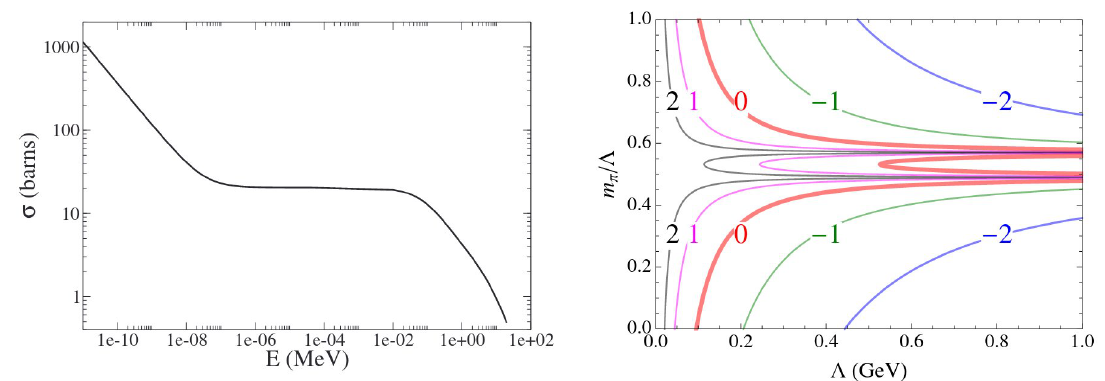
Figure 25: Left: actual neutron-proton scattering cross section as a function of center of mass energy. Plateau is the constant cross section of Eq. (50); at lower energies the [ σ/ m ] / [ 0.6cm 2 / g ] electromagnetic interaction dominates. Right: contours of log 10 in the plane of m π / Λ versus Λ for SU(3) gauge theory, from Ref. [ 33 ] . = 2.2 MeV, and σ ∼ 2 π/ ( Λ E ) gives a better estimate of the cross section. energy is E b b